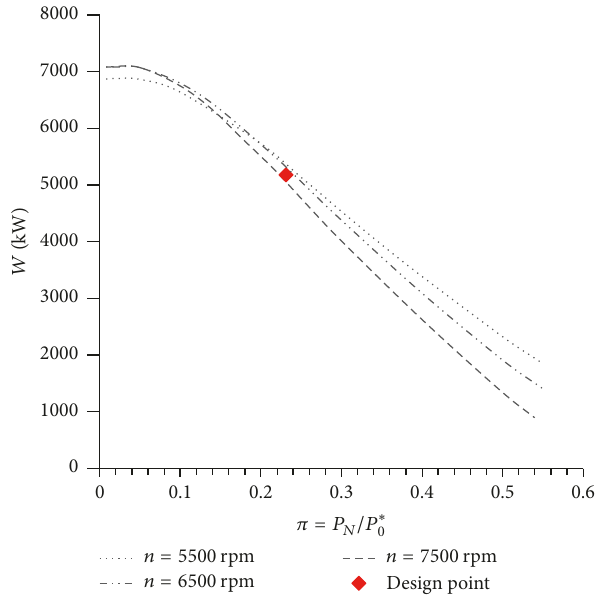
Figure 16: The variation of shaft power with pressure ratio at different